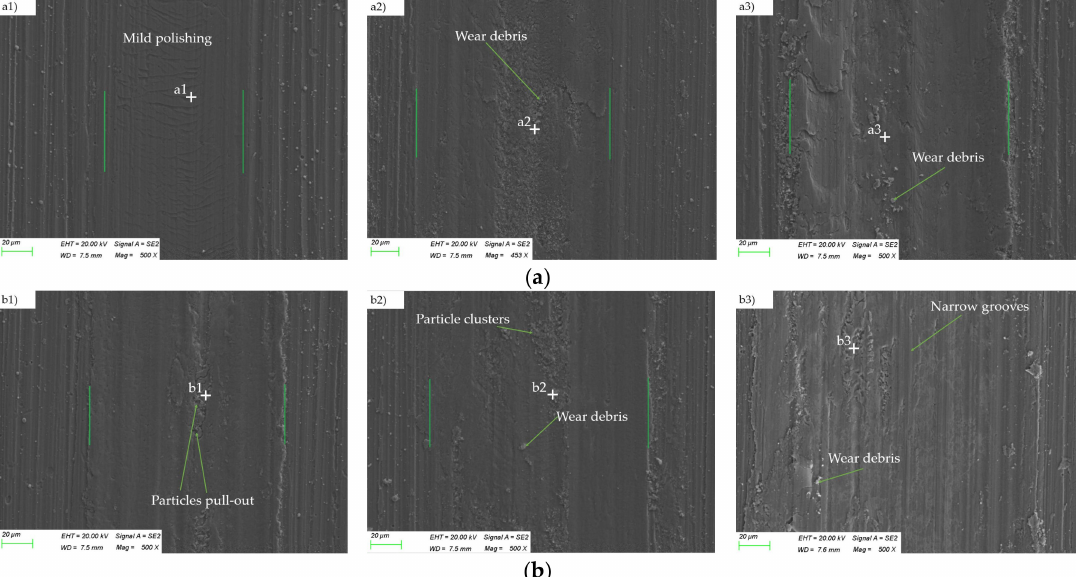
Figure 8. Morphology of the worn tracks on 5 µ m CrN coated M50 disks: ( a ) at the temperature of 25 ◦ C under the load of ( a1 ) 10 N, ( a2 ) 15 N, and ( a3 ) 25 N; and ( b ) at the temperature of 200 ◦ C under the load of ( b1 ) 10 N, ( b2 ) 15 N, and ( b3 ) 25 N. Table 2. The EDS analysis results corresponding to the positions in Figure 8.